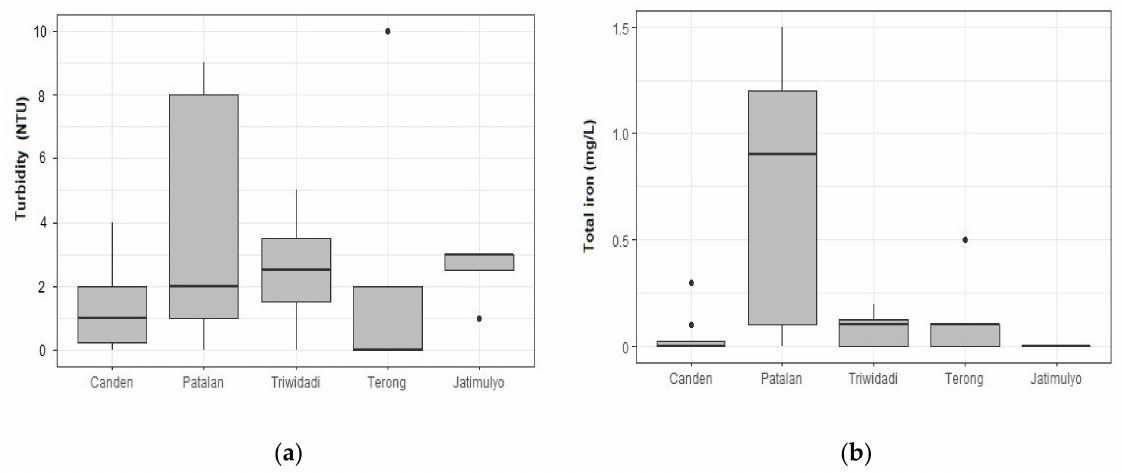
Figure 6. Groundwater quality in each village: ( a ) turbidity and ( b ) total iron concentration.